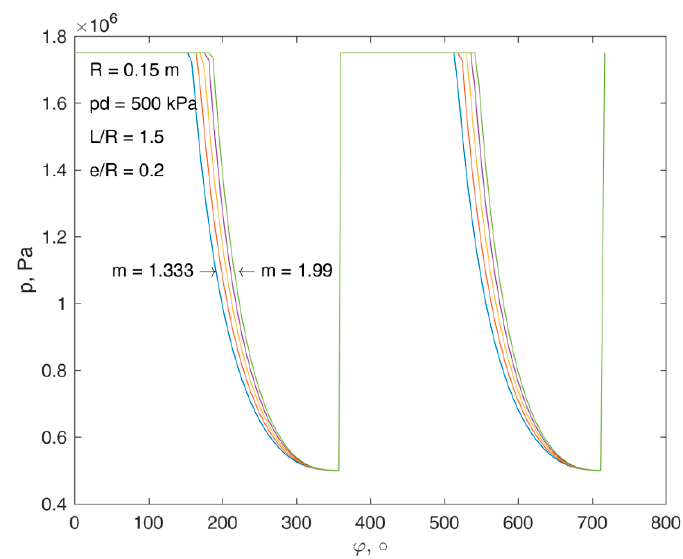
Figure 8. Pressure in a working chamber versus rotor rotation angle for different polytropic exponents ( m ), m = 1.333 (blue line), m = 1.4973 (red line), m = 1.6615 (orange line), m = 1.8258 (violet line), m = 1.99 (green line).